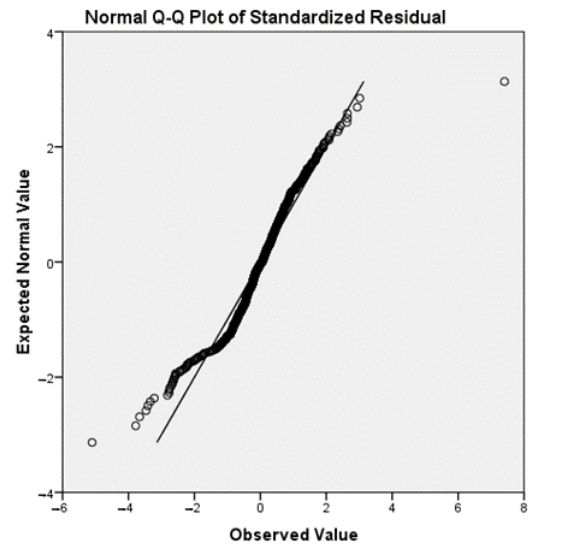
Figure 3. Q-Q plot of standardized residuals